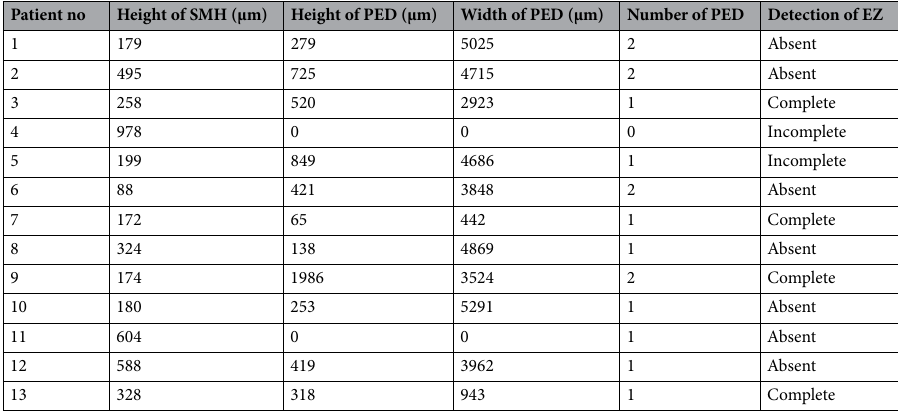
Table 2. Preoperative OCT findings.